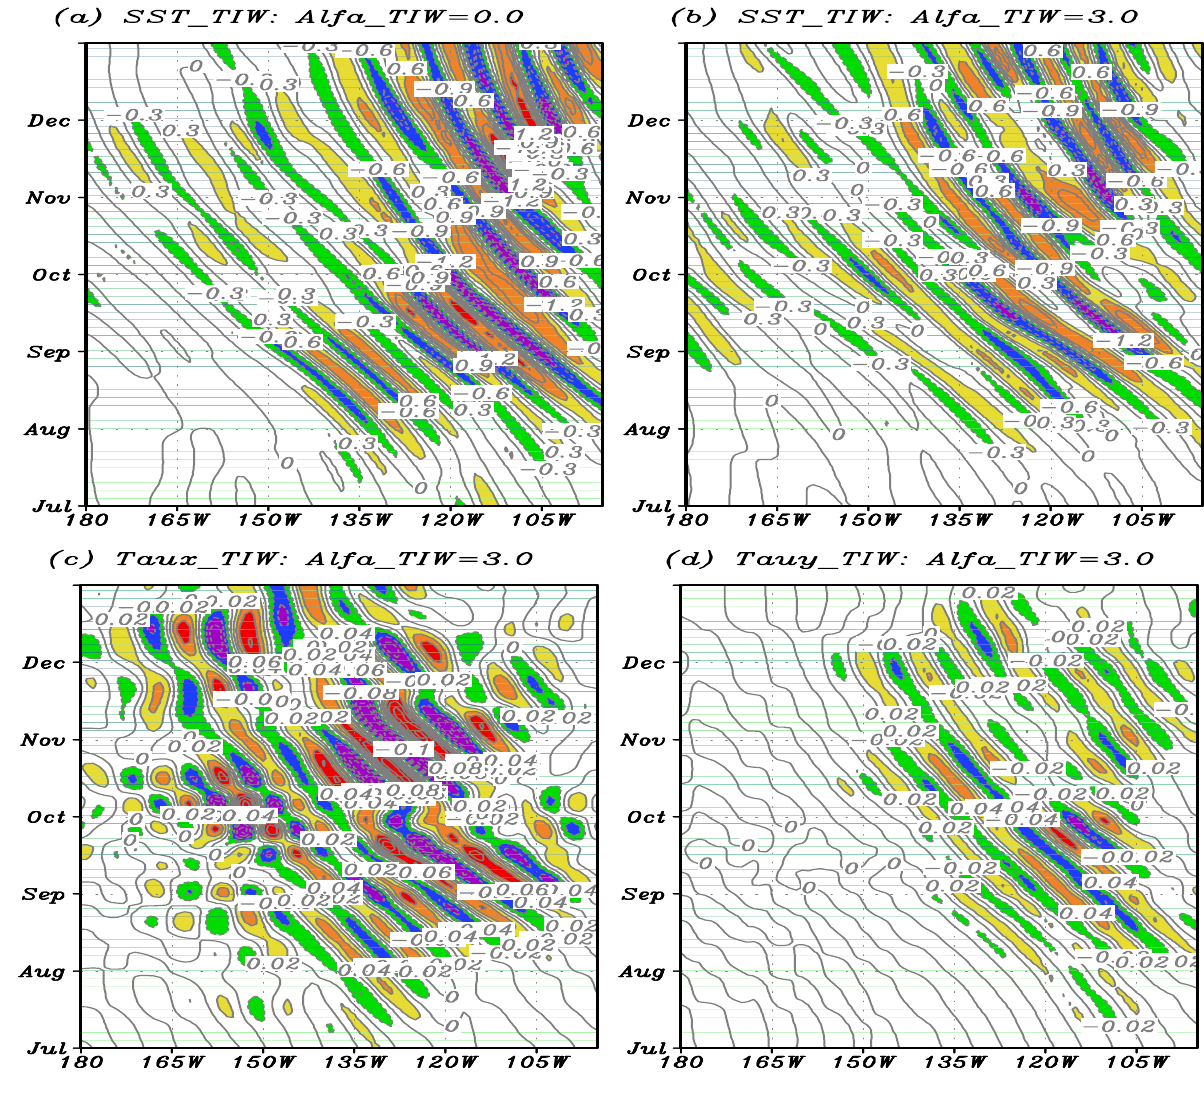
Figure 4. Longitude-time sections of the zonal-high-pass filtered fields along 2  N during July-December calculated from the ocean general circulation model (OGCM) simulations in year 13: the SST fields obtained from ( a ) the no-feedback run and ( b ) the feedback run, TIW and the ( c ) zonal and ( d ) meridional τ fields derived from the SST field shown in (b) TIW TIW using the empirical τ model with α = 3.0 and the first 10 SVD modes retained. The TIW TIW contour interval is 0.3 °C in (a,b), and is 0.02 dyn·cm −2 in